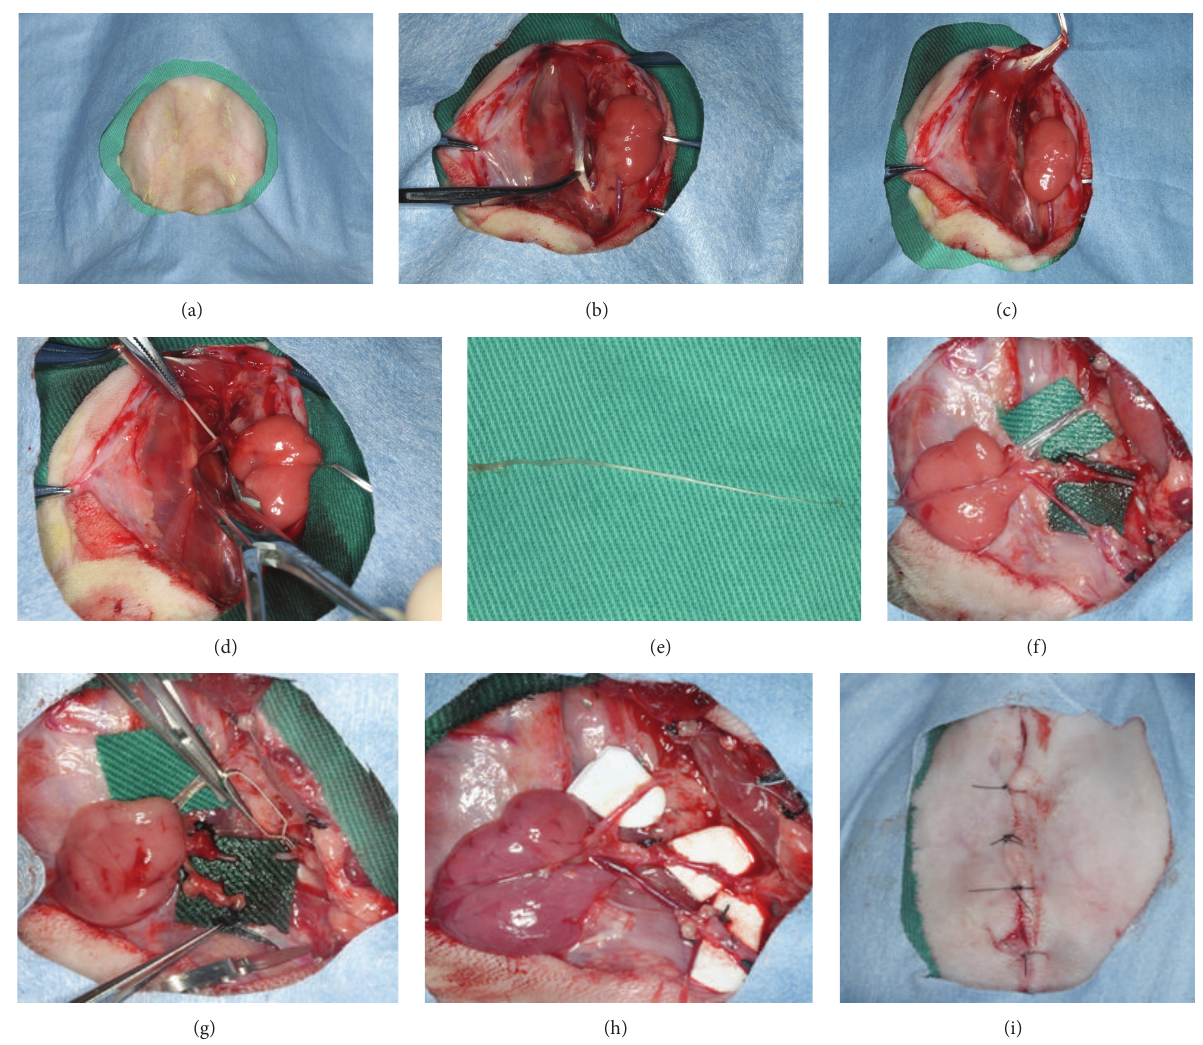
Figure 1: The surgical procedure of submandibular gland transplantation in animal model in rabbits ((a) skin preparation; (b) separation of anterior belly of digastric muscle; (c) cutting the digastric muscle tendon; (d) tearing the lingual nerve; (e) removing lingual nerve; (f) free submandibular gland with its blood vessels and Wharton’s duct; (g) cutting the artery and vein of submandibular gland; (h) anastomosis of artery and vein in normal position; (i) suturing layer by